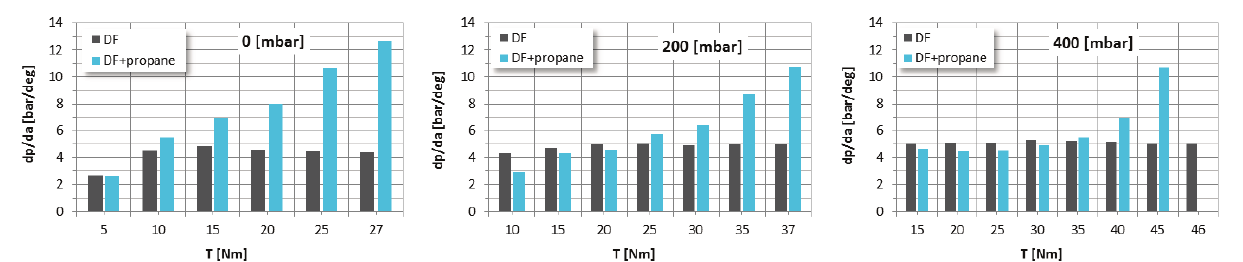
Fig. 9. Load characteristics of maximum rate of pressure rise (dp/d a ) max for both investigated engine operating